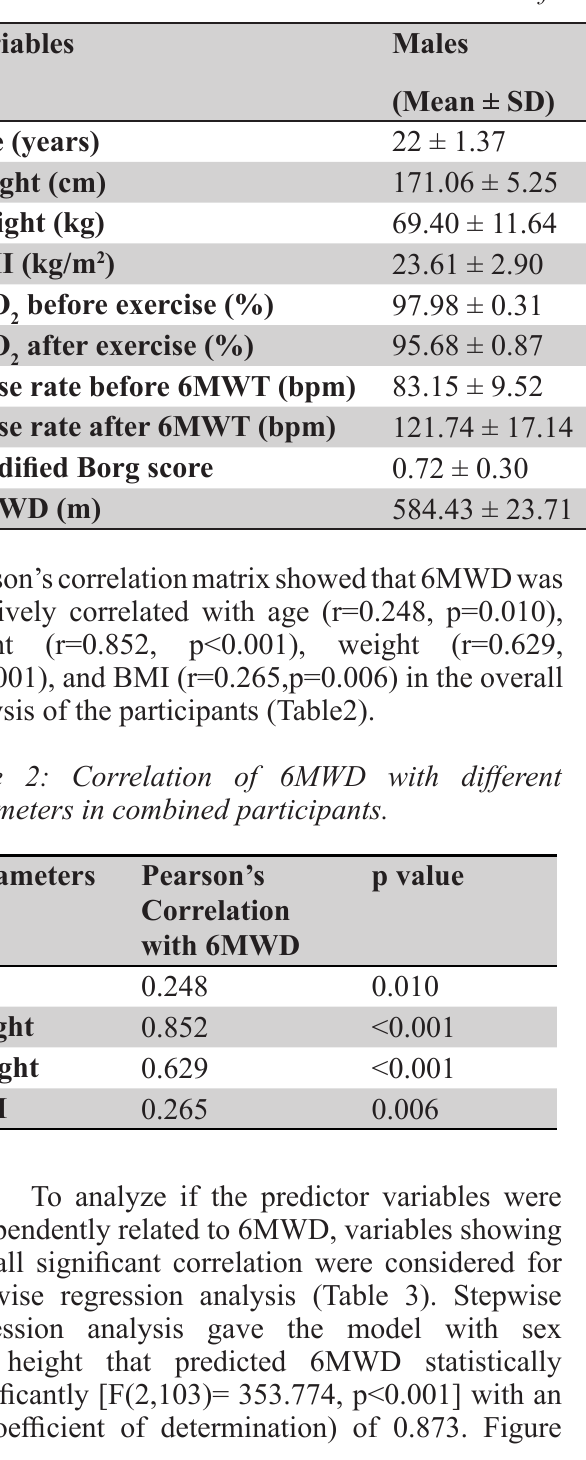
Table 1: Characteristics of the study participants (N=106)